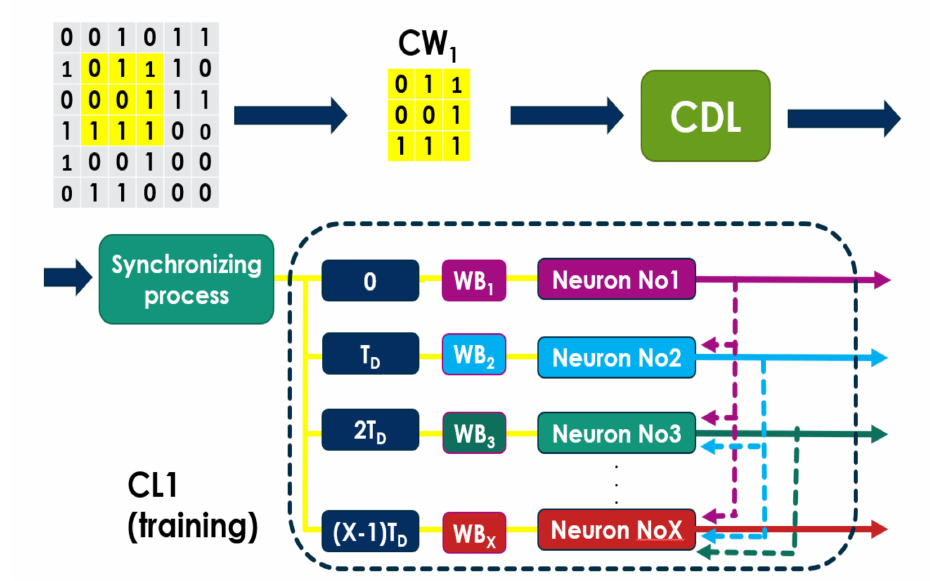
Figure 5. Block diagram of the first convolutional layer network during training. A specific area of the image is scanned by the contrast detection layer in order to detect pixels with high contrast (1 for black pixels and 0 for white pixels). After that the generated spikes are synchronized and entered into the neuron-VCSELs. Each neuron has its weight stored in a weight bank. When a neuron detects a pattern (fires a spike) it sends a cancelling signal to all of the following neurons (dashed lines). The training of the CL1 layer is based on STDP rule [37]. According to STDP, a neuron (post synaptic) updates its synaptic weights each time it produces a spike event. More spikes which arrived at the neuron before t 1 will have their corresponding synaptic weights t 1 will have their corresponding synaptic weights decreased (Figure 6 PRE 2